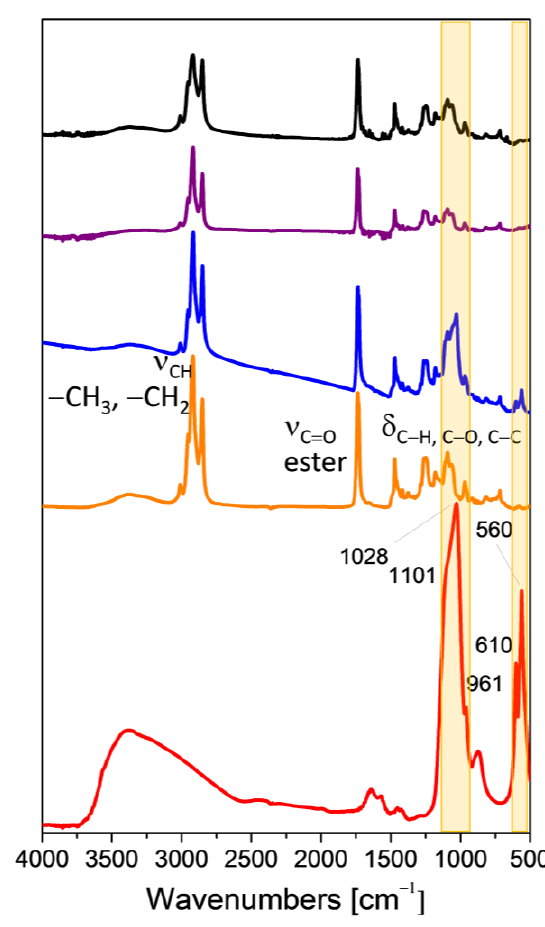
Figure 7. FTIR absorbance spectra of Ca 3 PO 4 (red line), NP NEG 1 (orange line), CaP-NP NEG 1B (blue line), NP POS 2 (purple line), and CaP-NP POS 2B (black line).